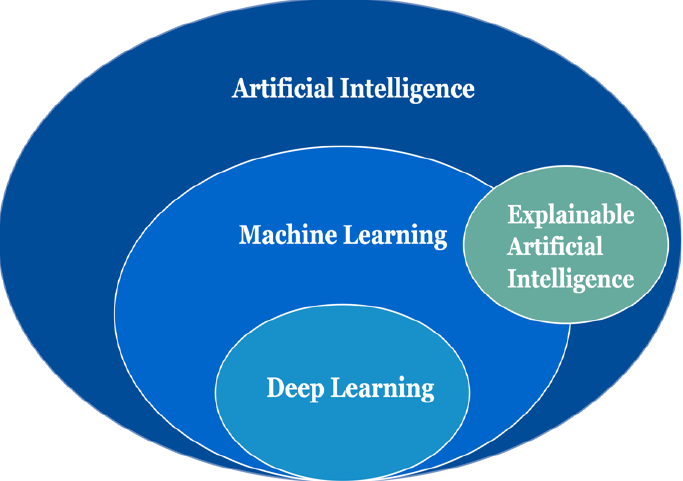
Figure 1. The relationship between artificial intelligence, machine learning, deep learning, and explainable artificial intelligence.